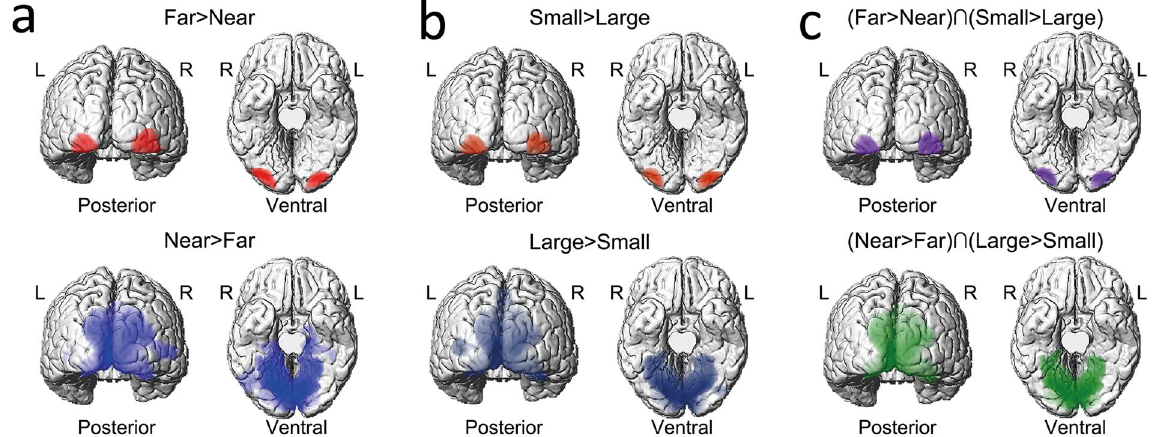
Figure 1. The main effect and conjunction result in the virtual 3D and 2D experiment. ( a ) Main effect of the depth of objects in the virtual 3D experiment. Red: “Far > Near”; Blue: “Near > Far”. ( b ) Main effect of the physical size of stimuli in the 2D experiment. Dark red: “Small > Large”; Dark blue: “Large > Small”. ( c ) The conjunction analysis between ( a ) and ( b